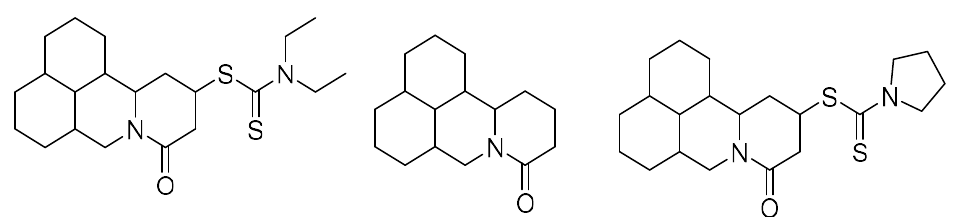
Figure 4. Chemical structure of active molecules derived from matrine.